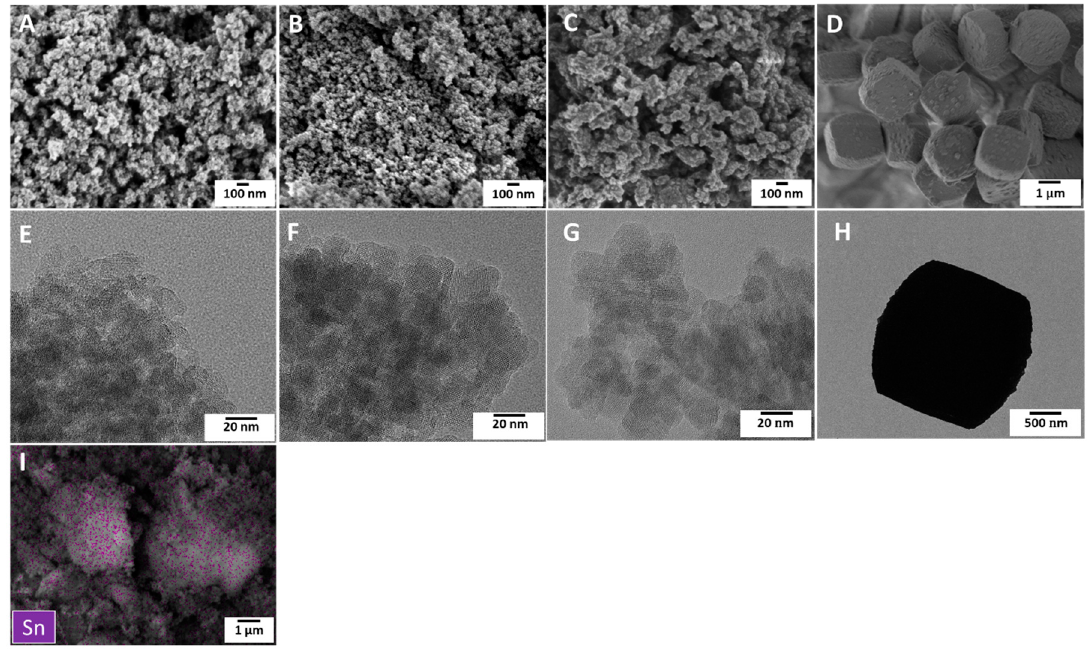
Figure 2. SEM and TEM images of: ( A , E ) the bare Beta, ( B , F ) the 0.4 wt% Sn-Beta, ( C , G ) the commercial Beta (Beta-COM), ( D , H ) the conventional ZSM-5 (ZSM-5-CON), and (I) the EDS Sn mapping of the in-situ synthesized Sn incorporated Beta (0.4 wt% Sn-Beta).